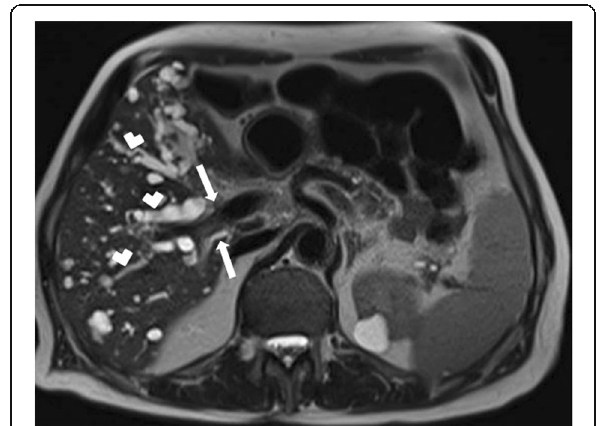
Fig. 4 A 60-year-old male patient with known PLD presenting with recent onset jaundice. Axial plane T2W MR image demonstrates innumerable cysts scattered throughout the liver parenchyma. Also, note is made of dilation in the intrahepatic bile ducts (arrowheads). This dilation abruptly ends at the confluence of the right and left hepatic ducts (arrow). The patient underwent endoscopic retrograde cholangiopancreatography and endoscopic brush biopsy confirmed Klatskin tumor.